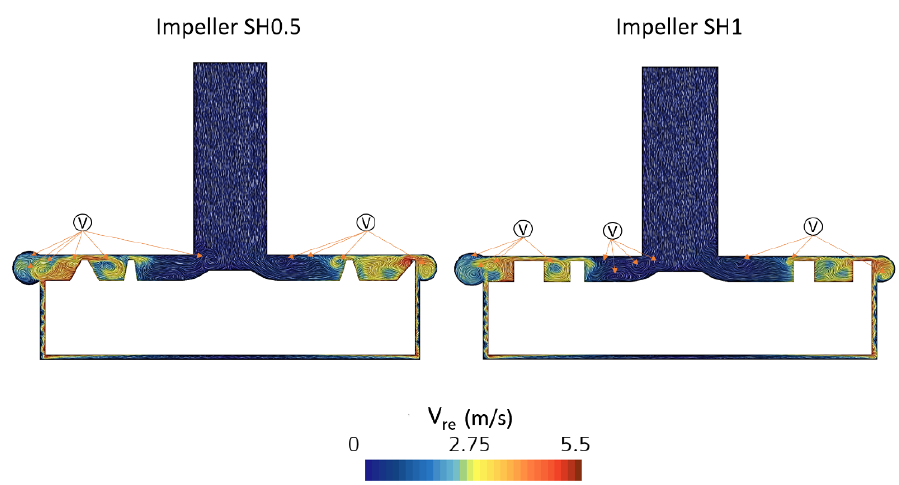
Figure 13. Relative velocity vector in the clearance gap for two pumps with impeller SH0.5 and SH1 (v in this fi gure indicates the vortices).